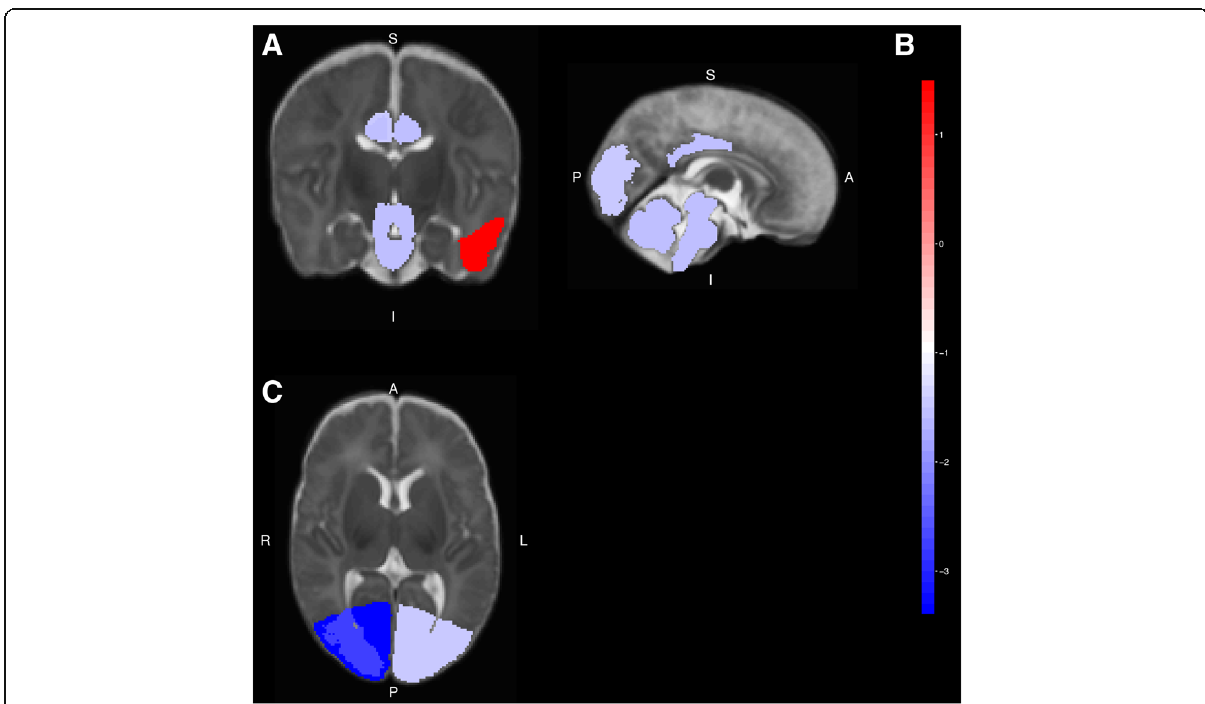
Fig. 1 Brain volume change of patients with pathogenic/likely pathogenic variants in CHD7 . Red color means volume gain and blue color means volume loss ( p < 0.05). ( a ) Coronal, ( b ) Sagittal, ( c ) Axial, R: Right; L: Left; A: Anterior; P: Posterior; I: Inferior; S: Superior